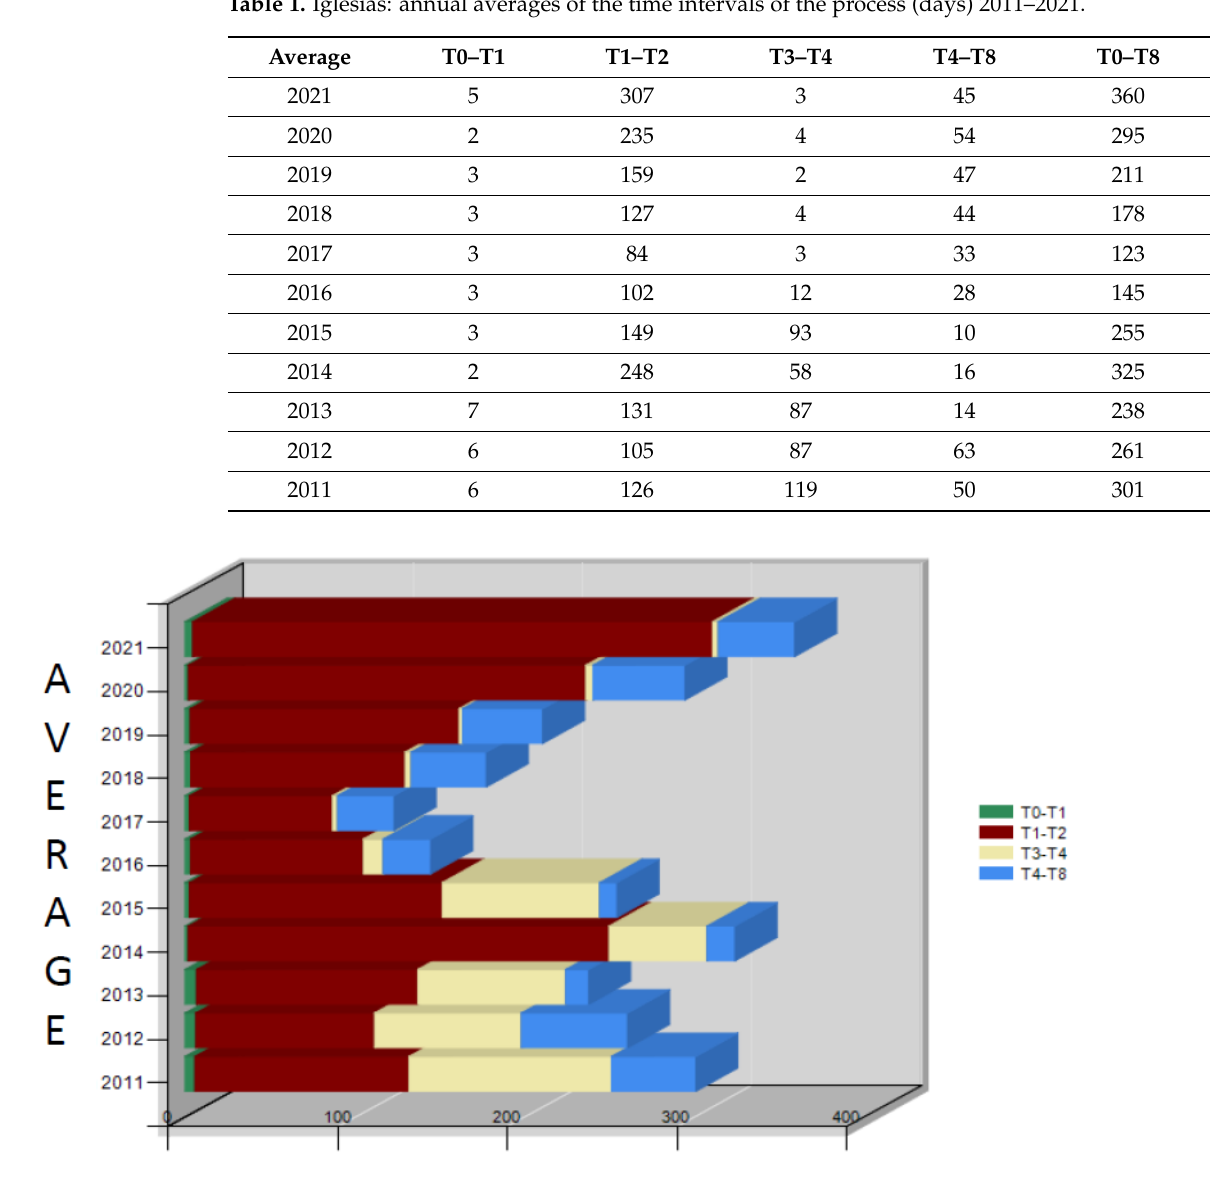
Figure 1. Dates of the disability assessment process.